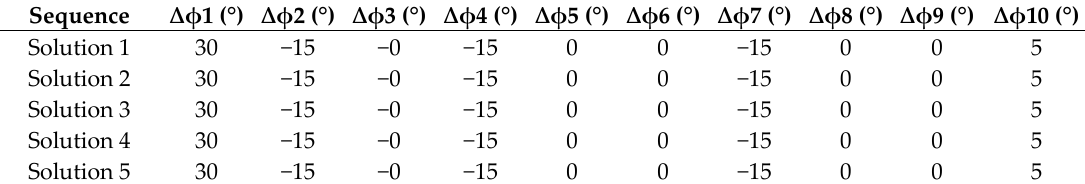
Table 7. Optimal solutions in a small angle crossing situation.